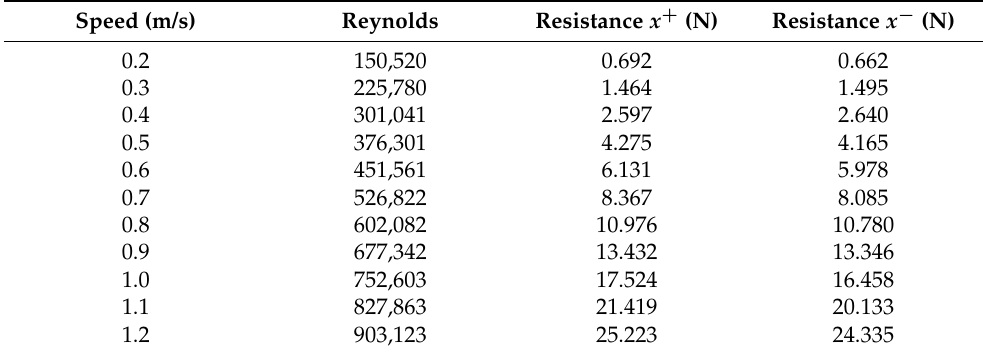
Table 5. Numerical results of towing test simulation when the underwater vehicle conducts straight- line motion in x